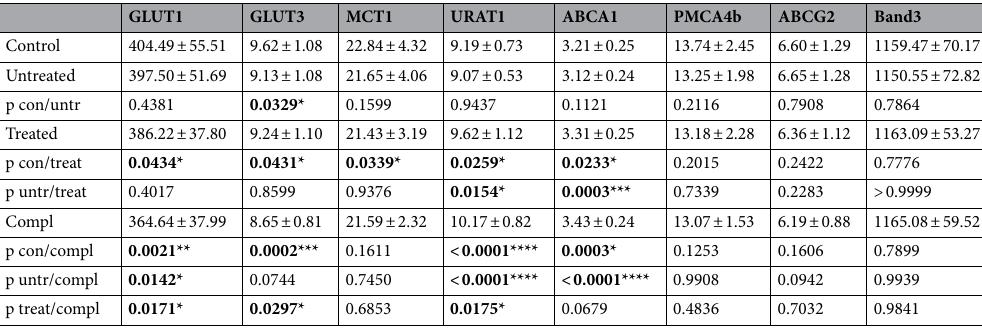
Table 3. Results of the Mann–Whitney analysis of membrane protein expression in control individuals and in T2DM patients grouped into recently diagnosed, untreated patients, successfully managed patients, and patients showing treatment resistance or disease-related complications. The protein expression values are expressed as means ± SD. n = 59 for all controls, except for MCT1 (n = 54), n = 36 for all recently diagnosed untreated T2DM patients, except for MCT1 (n = 31), n = 61 for all successfully managed T2DM patients except for MCT1 (n = 55), and n = 23 for all T2DM patients showing treatment resistance or disease-related complications.